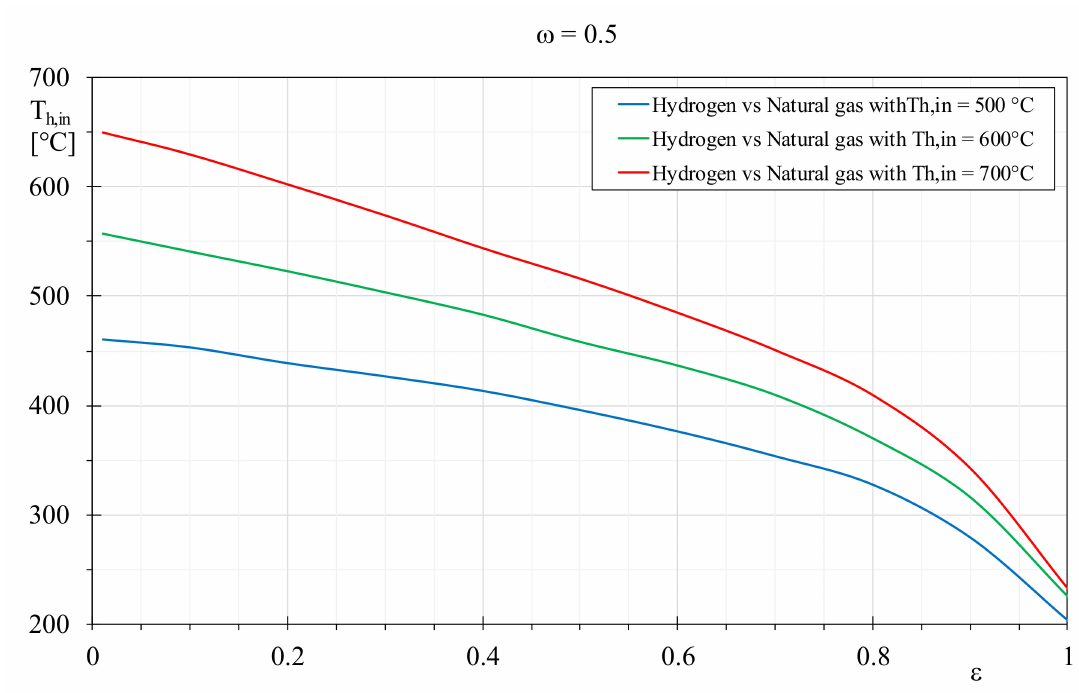
Figure 11. Hydrogen flue gas temperatures required to achieve the same EQI of natural gas with different combustion products temperatures, related to the heat exchanger efficiency and by setting ω = 0.5.